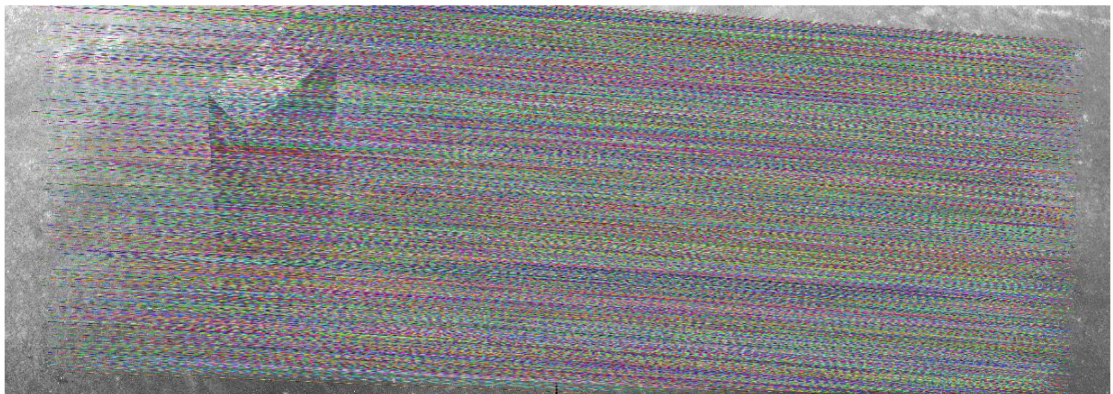
Figure 6. Image 2 matching numbers based on siftGPU.